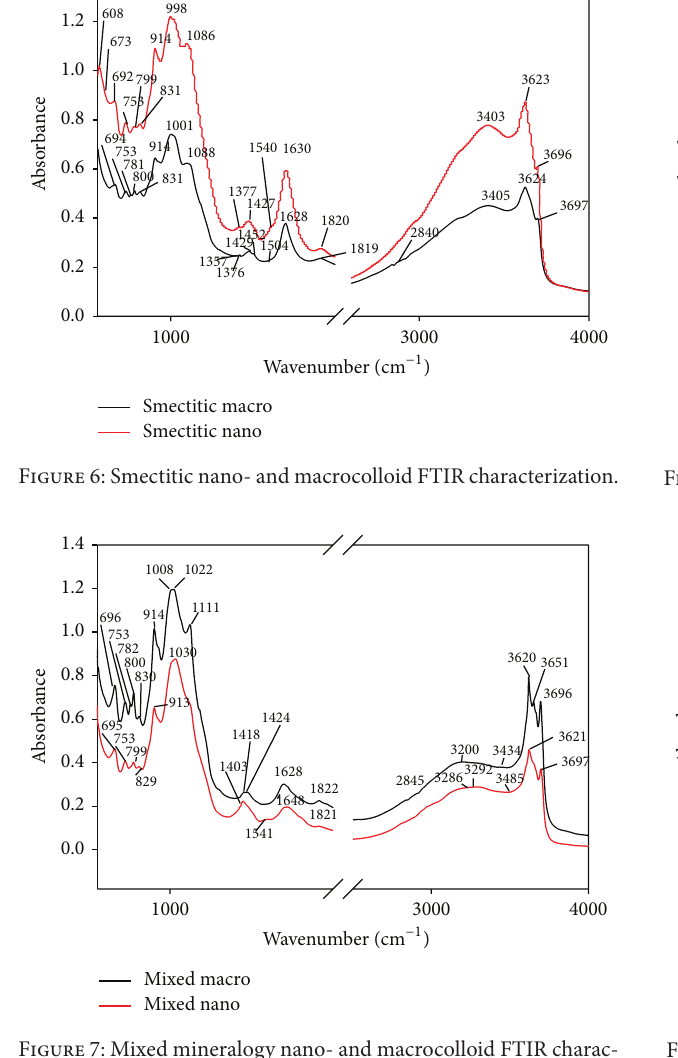
Figure 9: Biosolid nano- and macrocolloid FTIR